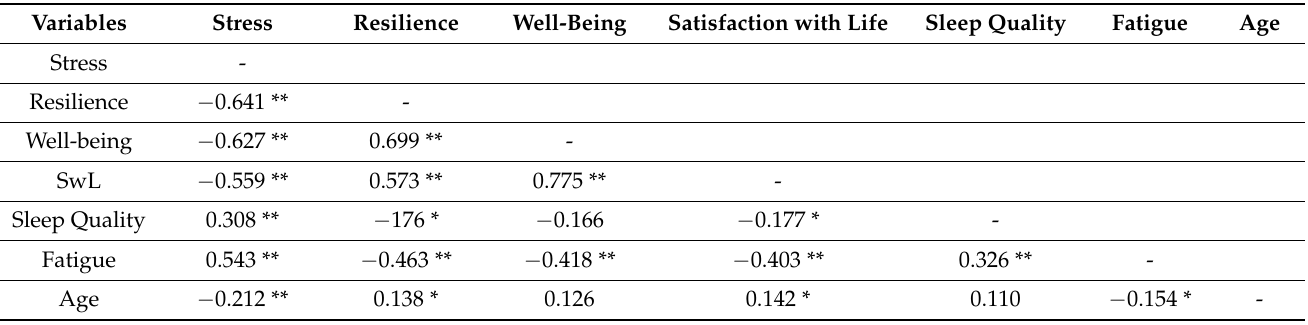
Table 4. Correlations between the dependent variables of the study as well as age.